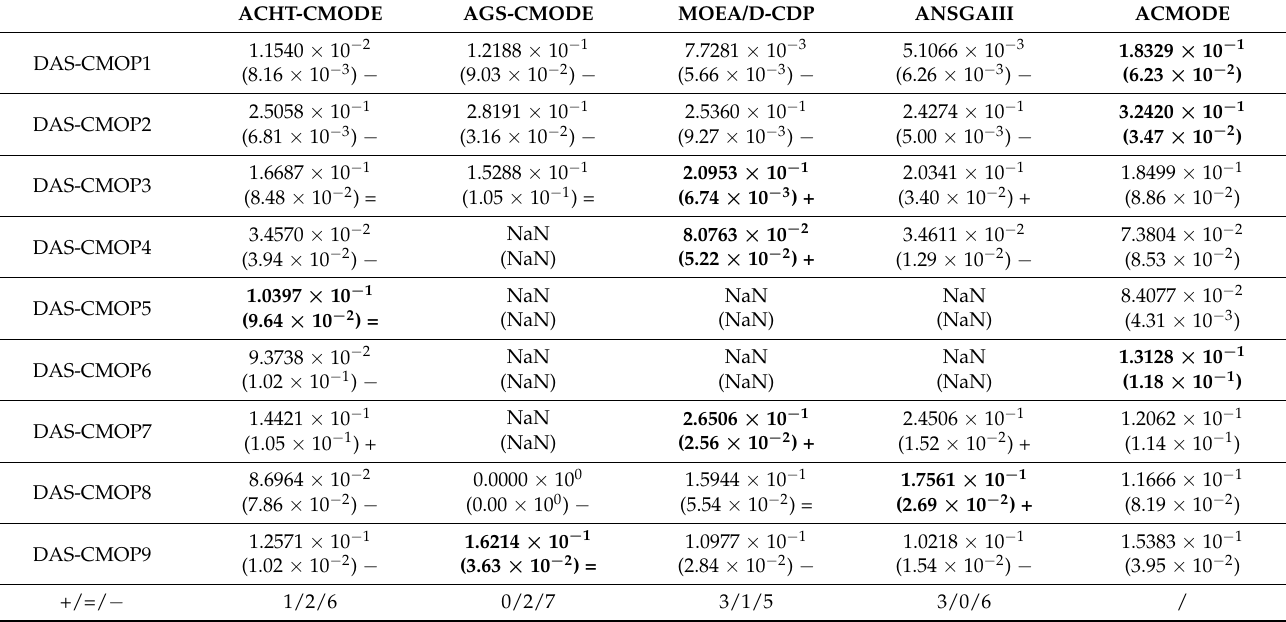
Table 11. HV results of all comparison algorithms on DAS-CMOP test